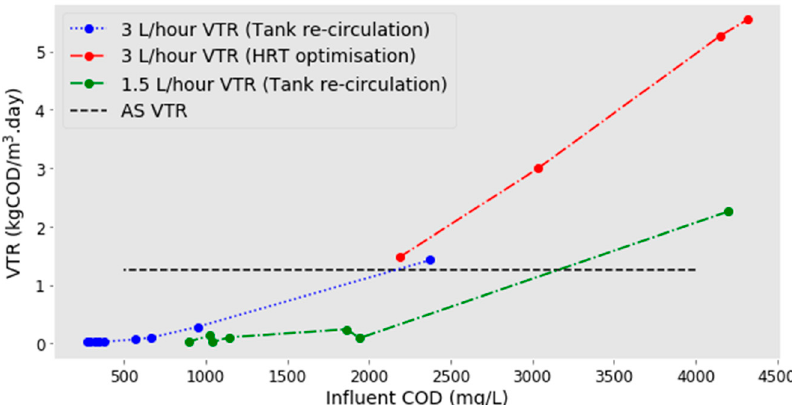
Figure 3. A graph to represent how the influent COD affects the VTR. Data collected during HRT